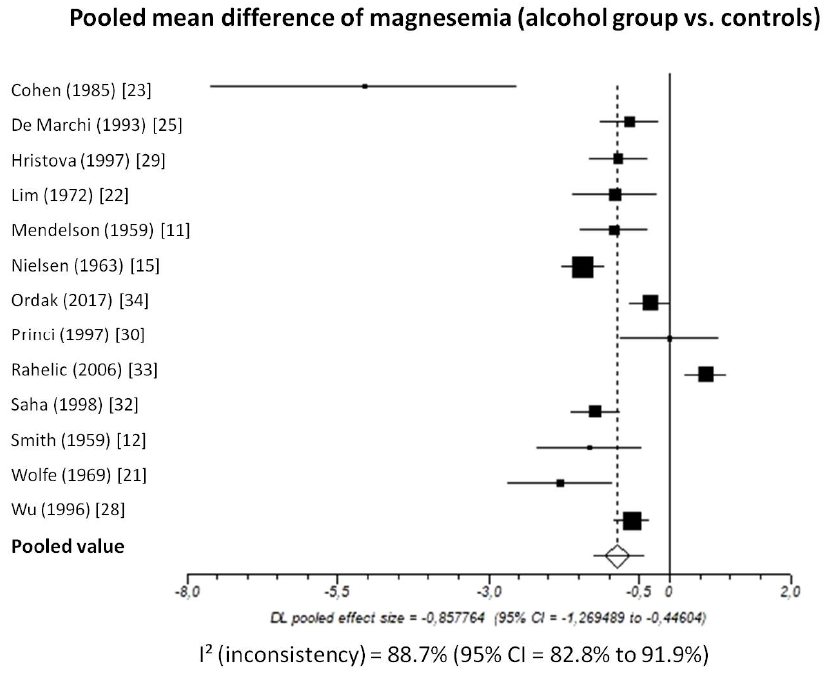
Figure 2. Forest plot of individual studies and pooled mean difference of magnesemia between alcohol group and controls, including 95% confidence intervals (95%-CI). The size of the squares is related to the weight of each study. Number of patients and control subjects in each study: Cohen [23]: controls n = 5, patients n = 5; De Marchi [25]: controls n = 42, patients n = 30; Hristova [29]: controls n = 40, patients n = 31; Lim [22]: controls n = 87, patients n = 9; Mendelson [11]: controls n = 18, patients n = 50; Nielsen [15]: controls n = 157, patients n = 48; Ordak [34]: controls n = 50, patients n = 100; Princi [30]: controls n = 14, patients n = 10; Rahelic [33]: controls n = 50, patients n = 105; Saha [32]: controls n = 75, patients n = 40; Smith [12]: controls n = 13, patients n = 12; Wolfe [21]: controls n = 12, patients n = 18; Wu [28]: controls n = 97, patients n = 88. I 2 -test was 88.7% (95%-CI: 82.8–91.9) demonstrating significant statistical